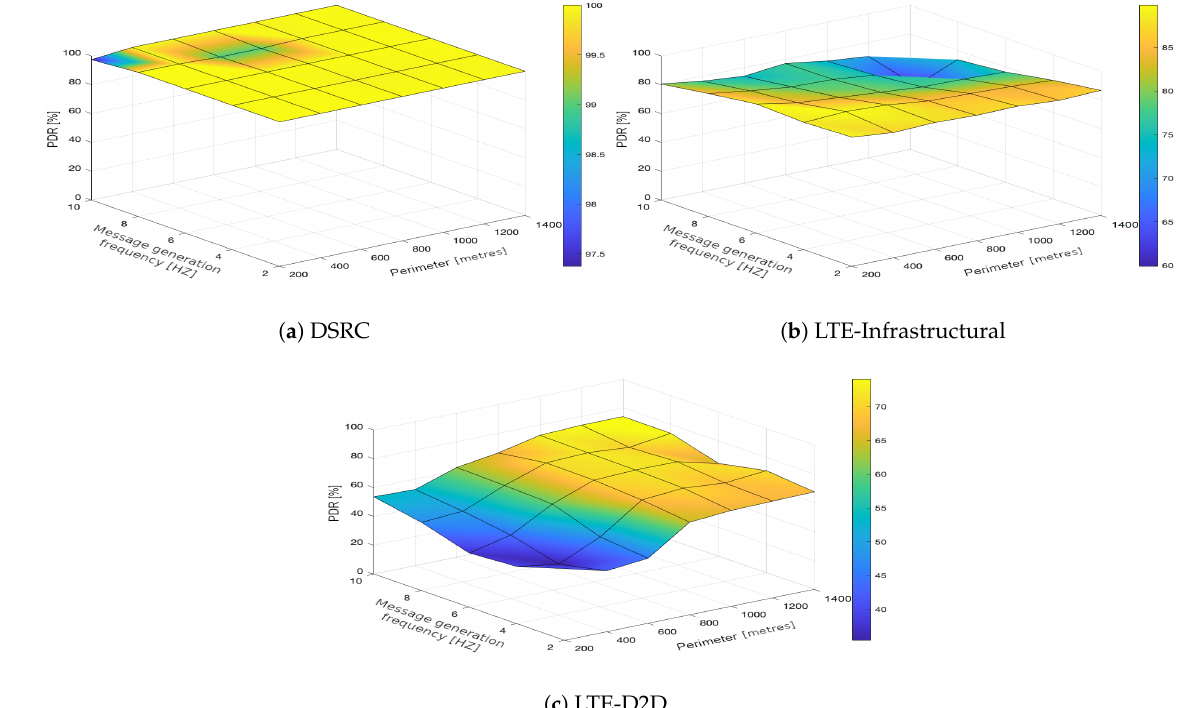
Figure 5. Packet delivery ratio obtained for the traffic intensity of 1000 vehicles per